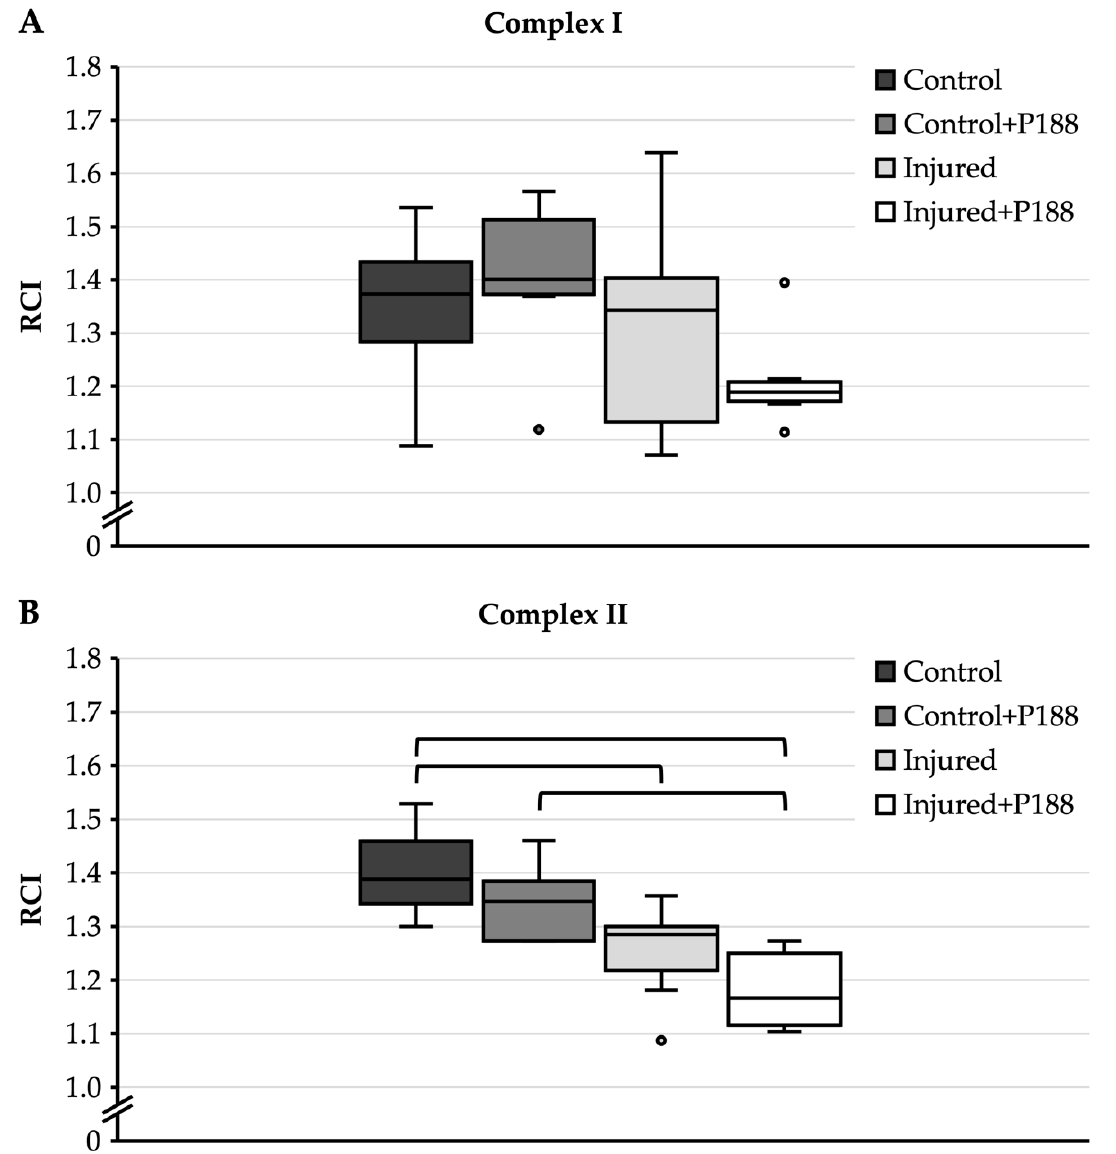
Figure 2. Respiratory control index (RCI) of oxygen (O 2 ) consumption in hydrogen peroxide (H 2 O 2 )-injured, isolated mitochondria for complex I ( A ) and II ( B ) substrates in control, control + Poloxamer (P)188, injured, and injured + P188 mitochondria. Boxplots show 25th, 50th, and 75th percentile; whiskers represent minimum and maximum. Statistical significance ( p < 0.05) denoted by brackets; complex I: n = 6, complex II: n =